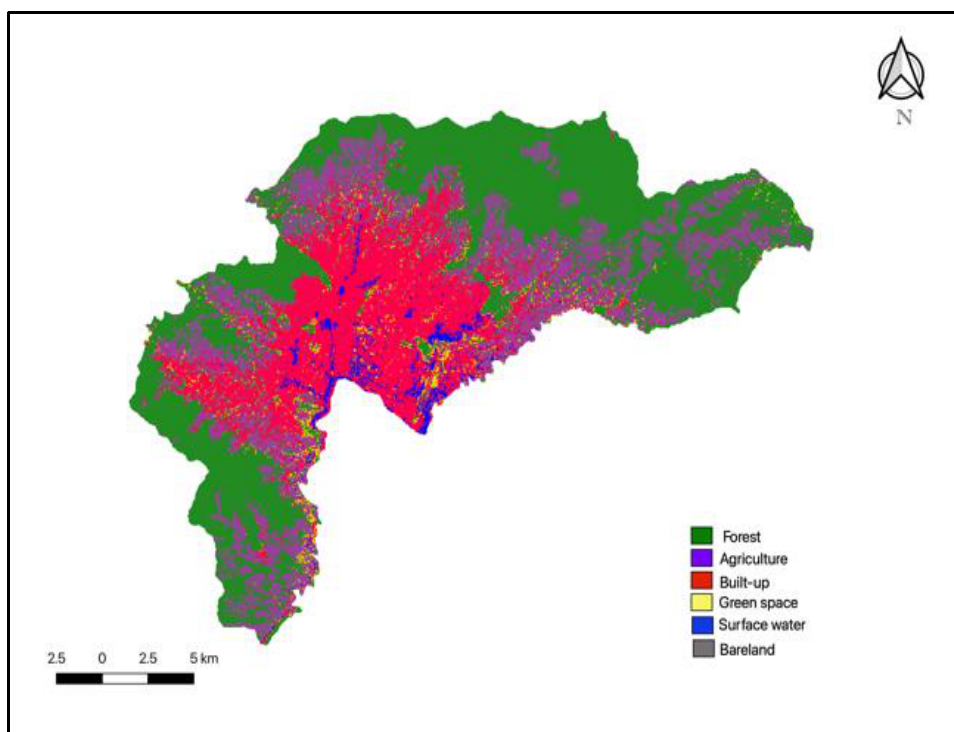
Figure 5. Land cover map for year 2021.